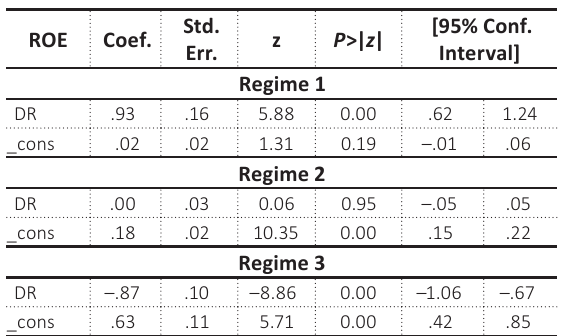
Table 2. The threshold model with two thresholds